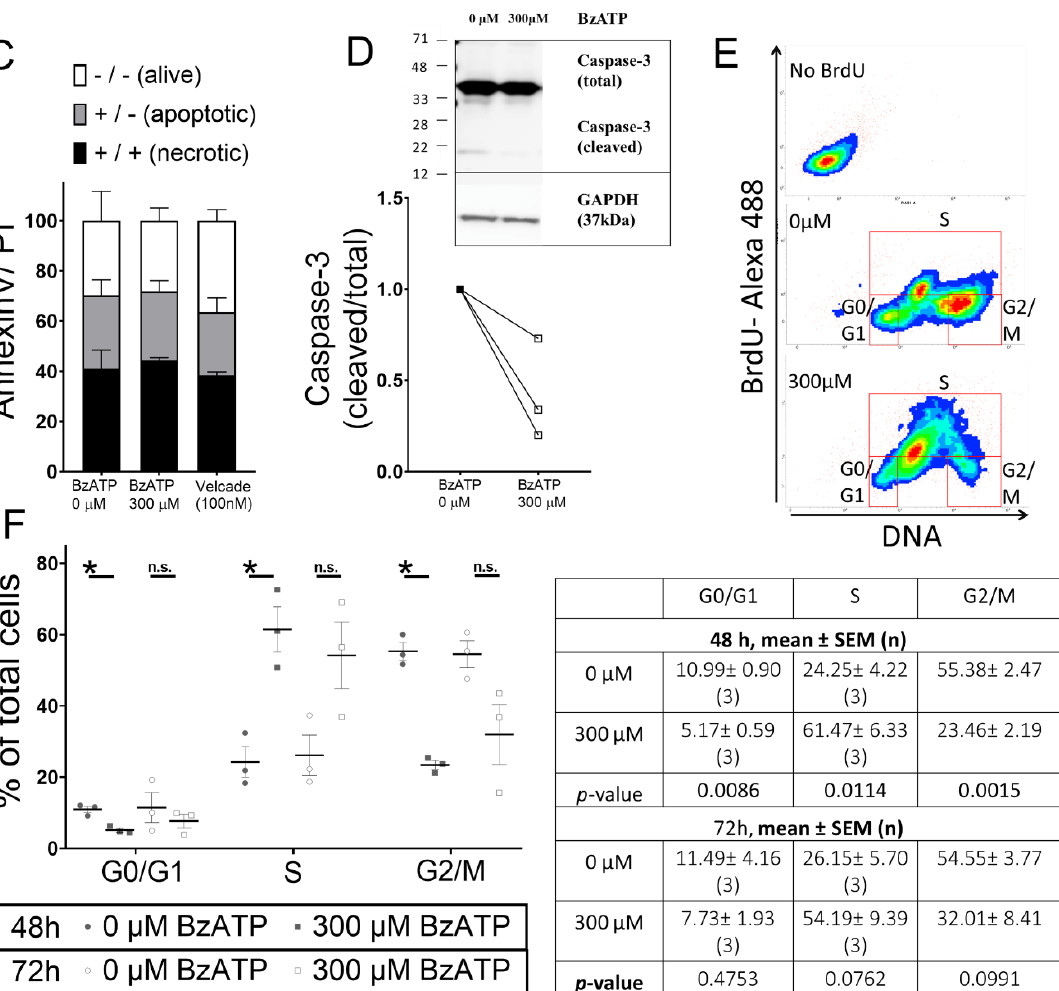
Figure 3. P2X7 receptor induced cell cycle arrest but not apoptosis in RPMI-8226. ( A ) Viability as a measure of metabolically active and ( B ) DNA content (pg / well) of RPMI-8226 cells after 48 h with BzATP is plotted as a percentage of control (0 µ M BzATP, dotted line). Velcade (100 nM), an anti-myeloma agent, was used as a positive control. Data shows mean ± SEM of three independent experiments; Kruskal–Wallis comparison to show * = p < 0.05 multiple corrections of each treatment to 0 µ M BzATP (# = p < 0.05, ### = p < 0.001 Mann–Whitney test for 0 µ M BzATP vs. Velcade). ( C ) Flow cytometry to assess the percentage of alive (annexin V- / PI-), apoptotic (annexin V +/ PI-), and necrotic (annexin V +/ PI + ) cells after 48 h with 300 µ M BzATP. Data shows mean ± SEM of four independent experiments. ( D ) Western blot analysis to quantify caspase-3-cleaved protein (17 kDa) as a ratio of total protein (35 kDa) after 48 h with 300 µ M BzATP; GAPDH was probed as a loading control ( n = 3). ( E ) Scatter diagrams representing the populations in G0 / G1, S, and G2 / M phases of the cell cycle as determined by flow cytometry and ( F ) analysis following a 2-h BrdU pulse showing the percentage of cells in each cell cycle phase after 48 and 72 h treatment with 300 µ M BzATP. Data shows mean ± SEM of three independent experiments, where * = p < 0.05 by Mann–Whitney test compared to 0 µ M BzATP in